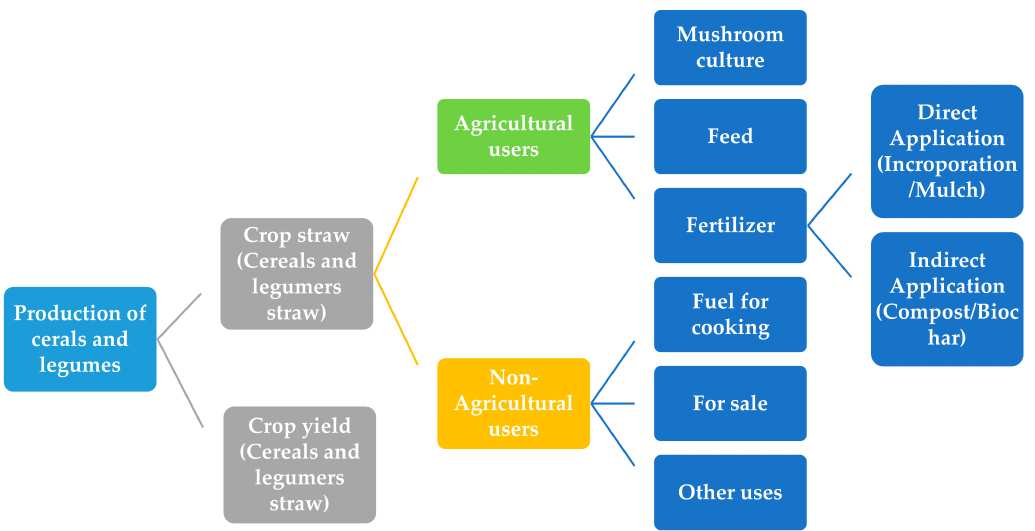
Figure 1. Scheme of legumes and cereals